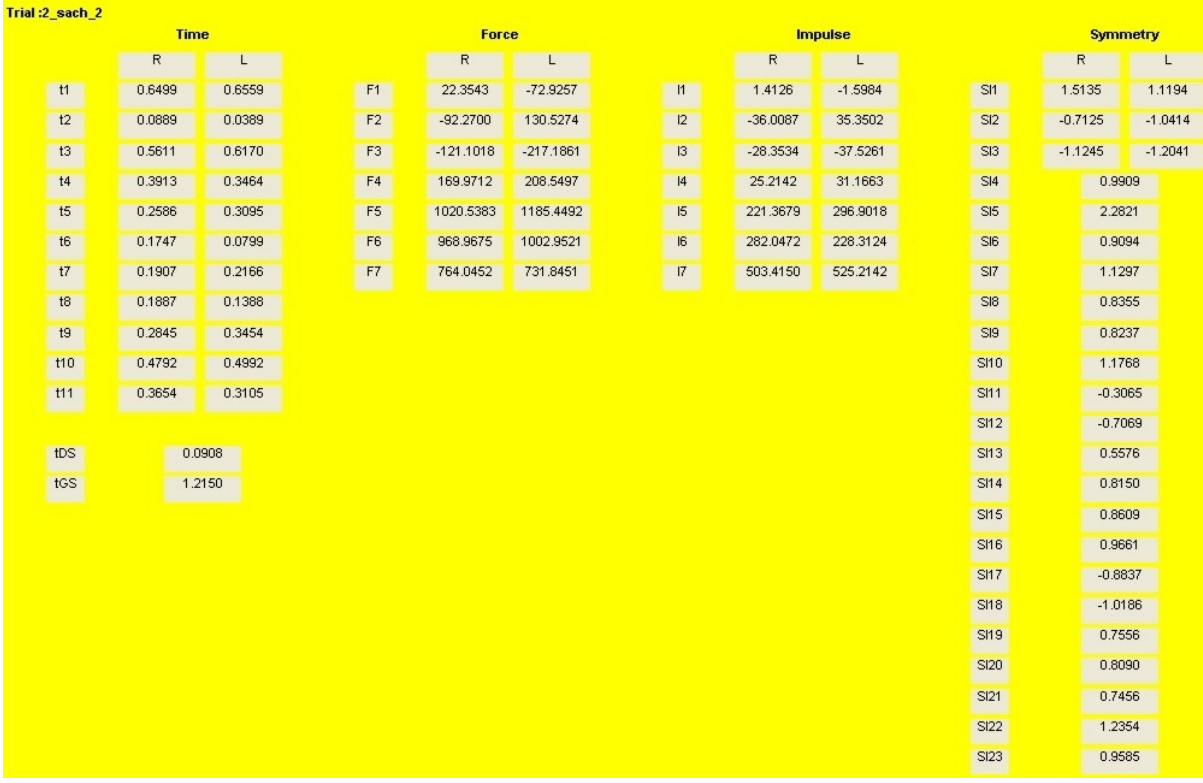
Figure 4. Gait analysis, the final outcome of computed variables. R = right lower extremity, L = left lower